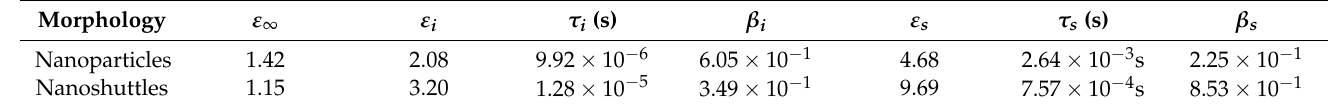
Table 4. Cole—Davidson parameters for nanoparticles and